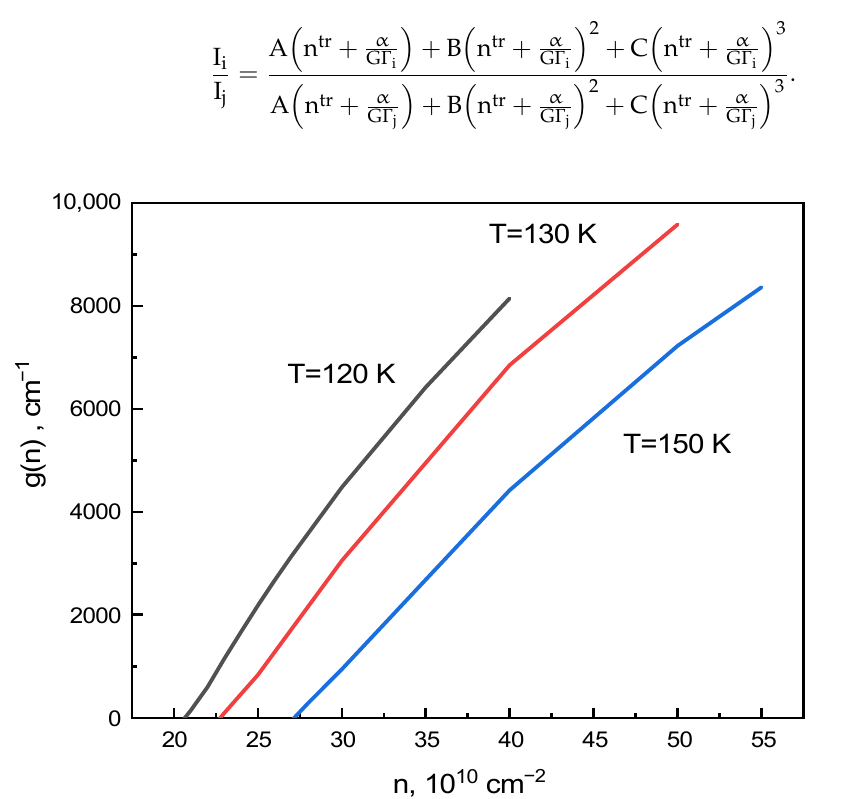
Figure 3. Calculated dependence of g(n) for 2.7 nm wide Hg 0.23 Cd 0.77 Te/Hg 0.1 Cd 0.9 Te/Hg 0.23 Cd 0.77 Te QW for three temperatures: 120 K, 130 K, 150 K.